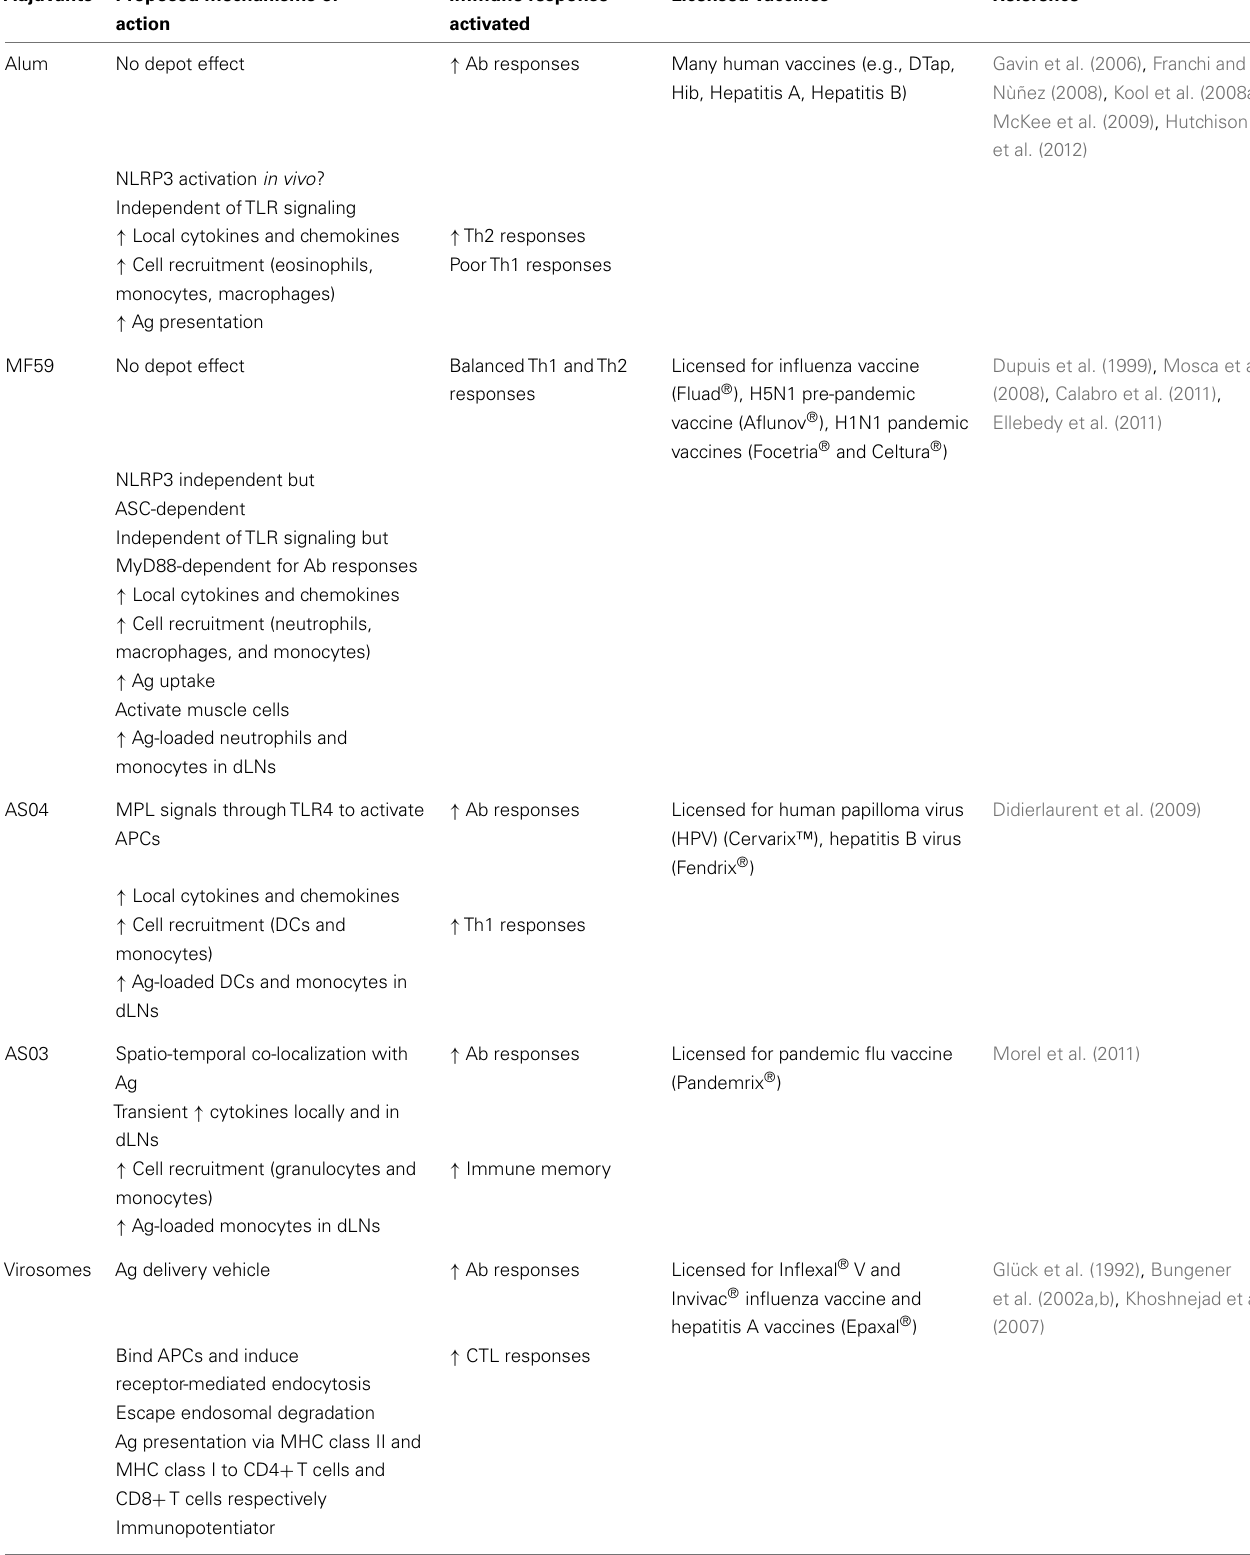
Table 1 | Mechanisms of action of adjuvants licensed for human use. Adjuvants Proposed mechanisms